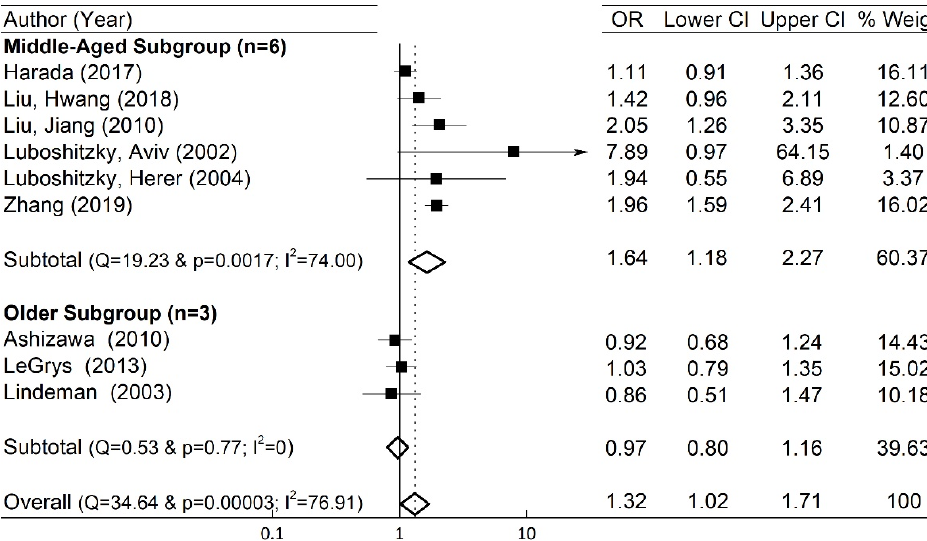
Figure 5. Subgroup analysis forest plots in the middle-aged ( n = 6) and the older ( n = 3) subgroups. % weight is from the random-effects model in the whole studies ( n = 9). OR for each individual study in each subgroup is denoted by a solid square (  ), while its CI is represented by a horizontal line. The centers and the widths of the diamonds (  ) represent the pooled OR and CI in each sub- ) represent the pooled OR and CI in each subtotal case total case and the overall case, respectively. (cid:51) and the overall case,